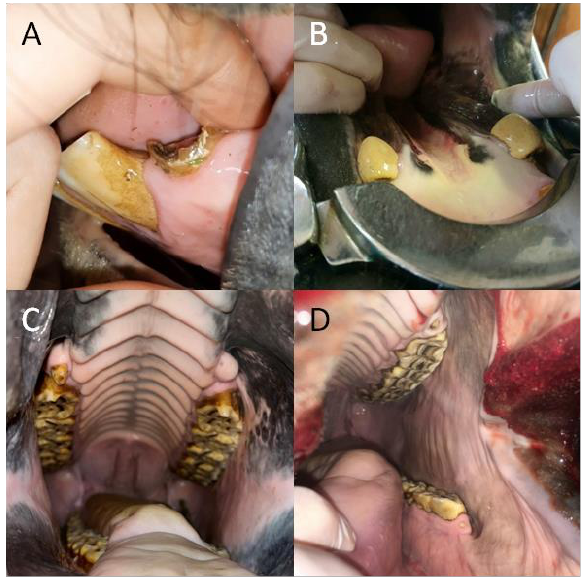
Figure 5. The samples of the malocclusions and dental diseases of the canine and wolf teeth in horses. For the canine teeth: fractures ( A ) and calculus ( B ). For the wolf teeth: blind wolf tooth ( C ) and fractures ( D ).